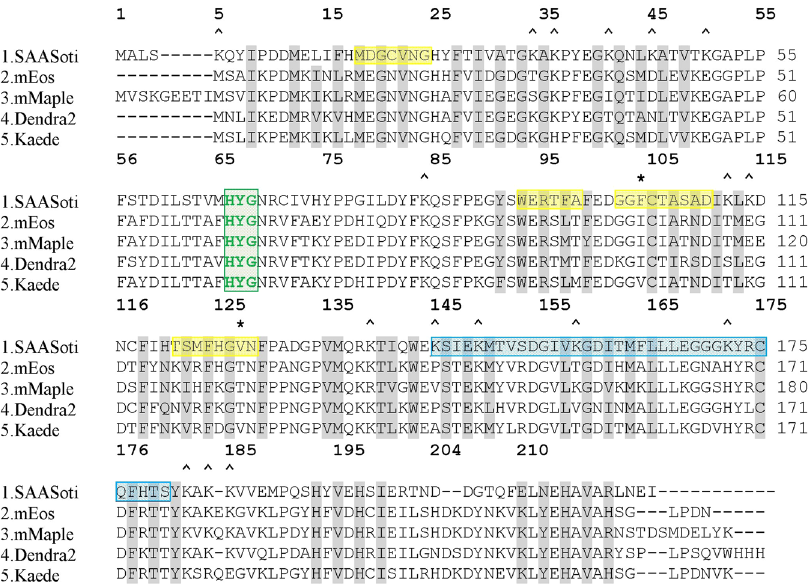
Figure 3. Sequence alignment of different photoconvertible FPs. Chromophore forming amino acids are shown in green; hydrophobic AC interface is highlighted in yellow; charged AB interface is highlighted in blue; ^ – marks all lysine residues; amino acid residues facing into the β -barrel are highlighted in grey. Amino acid residues substituted by site-directed mutagenesis – V127, K145, K149 and K172 – are shown in red. 1, 5 etc. – SAASoti amino acid